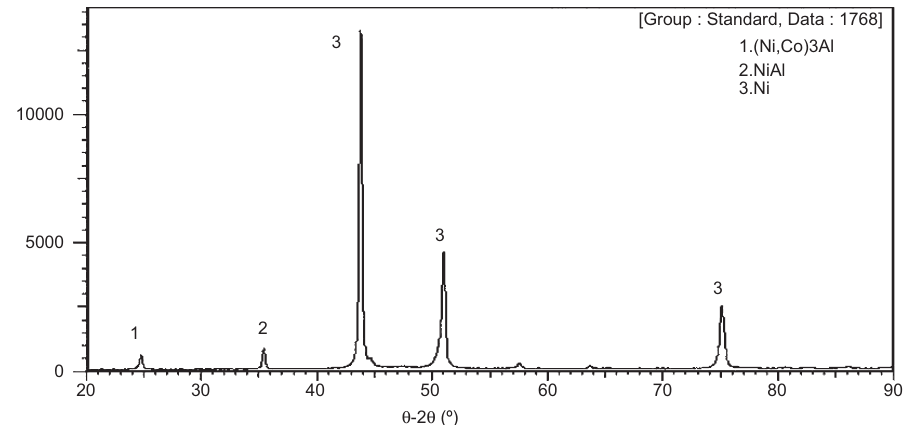
Figure 2 X-ray diffraction (XRD) graphic of Ni+Al+3% Co composite material.